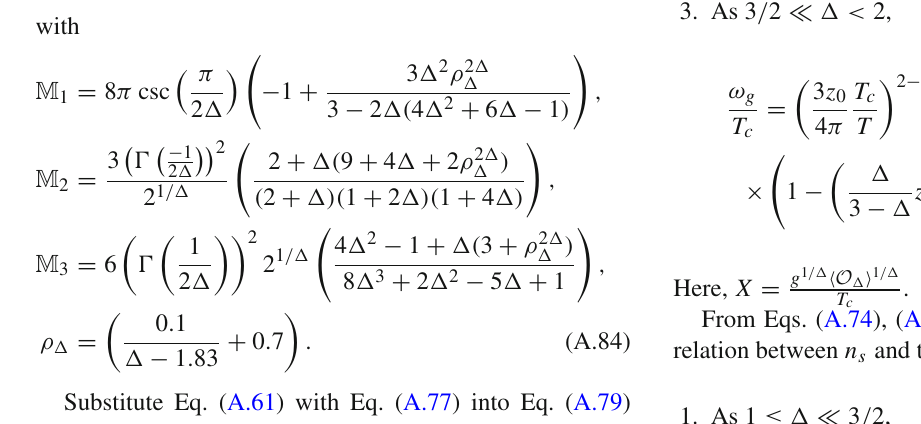
and blue one is a plot of